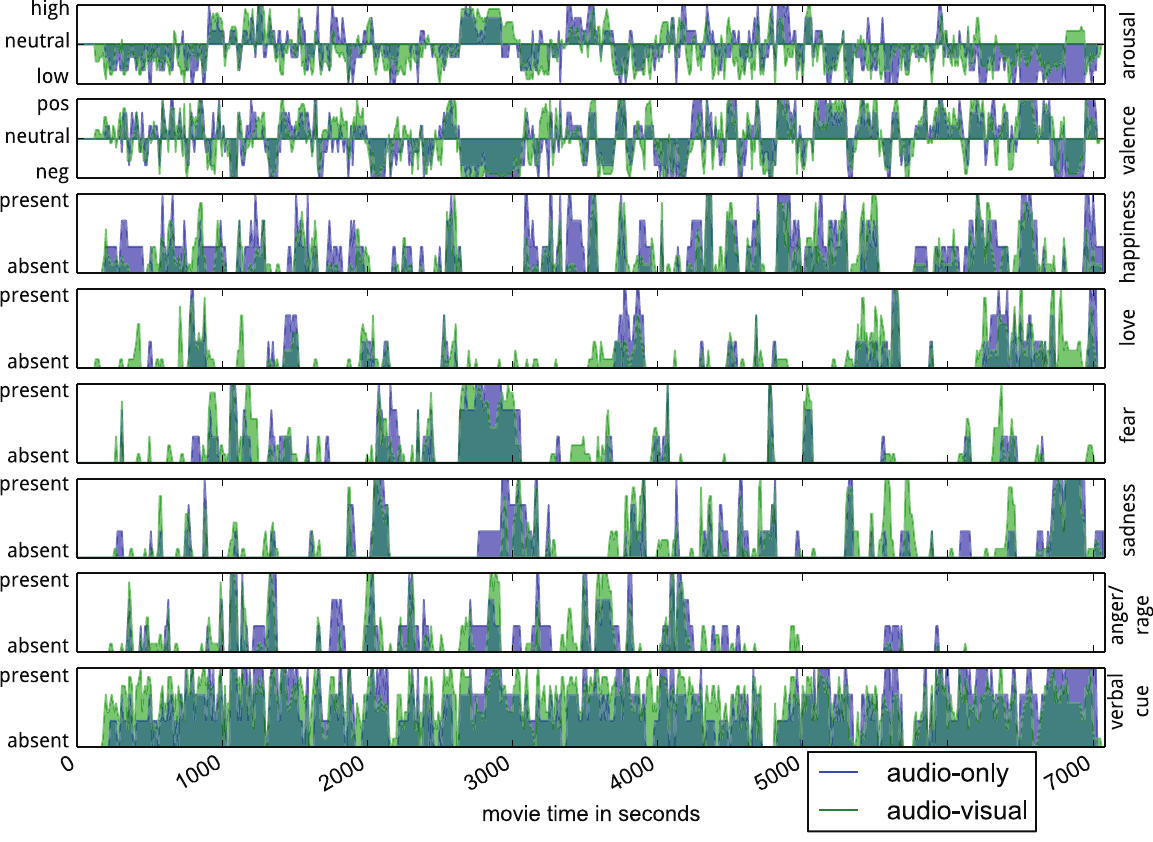
Figure 3. Inter-observer agreement (IOA) time courses for selected emotion attributes across the full duration of the movie. Extreme values indicate perfect agreement with respect to presence or absence of a particular emotion attribute at a given time. IOA time series for the two movie types are overlaid on top of each other. For the purpose of visualization, the depicted time series reflects IOA computed using a 10 s segment size — in contrast to 1 s used for all other statistics presented in this